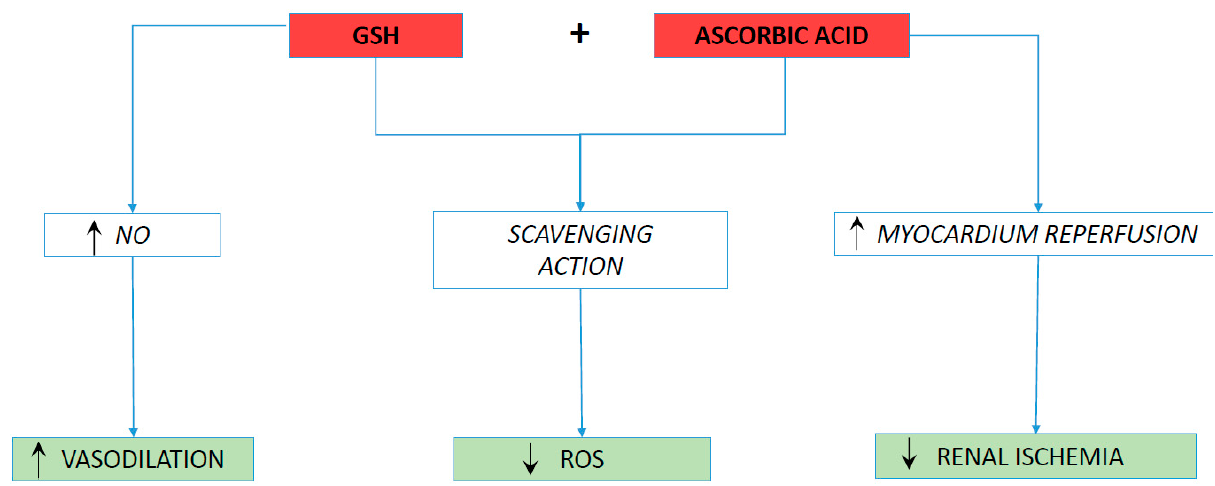
Figure 2. Graphical summary of our hypothesis. GSH: Glutathione; NO: nitric oxide; ROS: Reactive Oxygen Species.